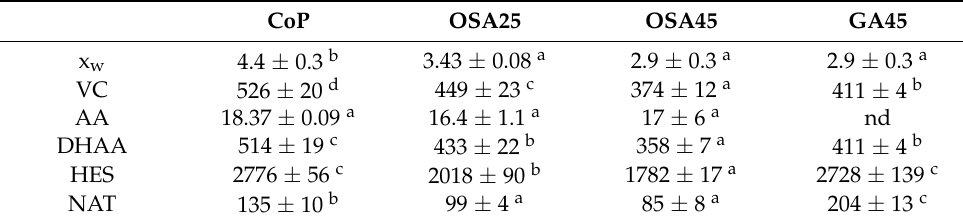
Table 3. Mean water (x w , g water/100 g analyzed sample) and bioactive compound content (mg/100 g analyzed sample) of the different freeze-dried formulations (codes according to Table 1): vitamin C (VC), ascorbic acid (AA), dehydroascorbic acid (DHAA), hesperidin (HES), and narirutin